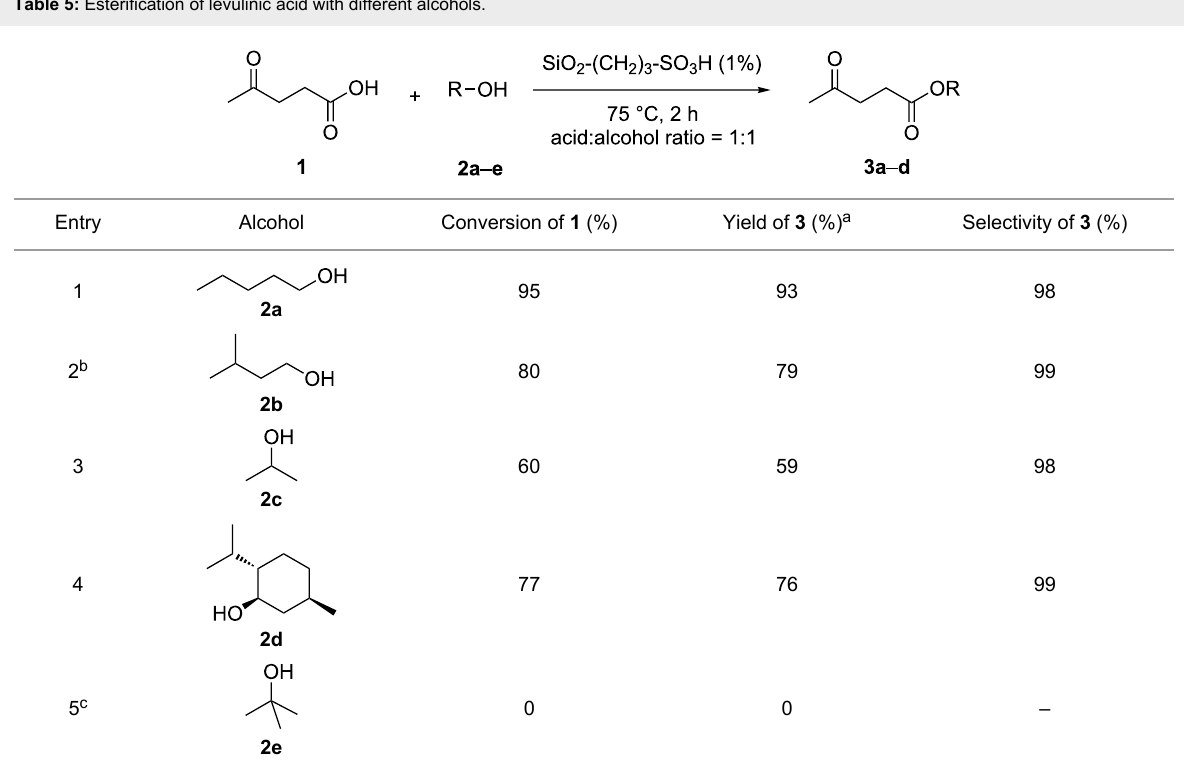
Table 5: Esterification of levulinic acid with different